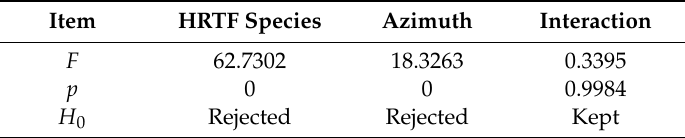
Table 5. Result of two-way repeated variance analysis.